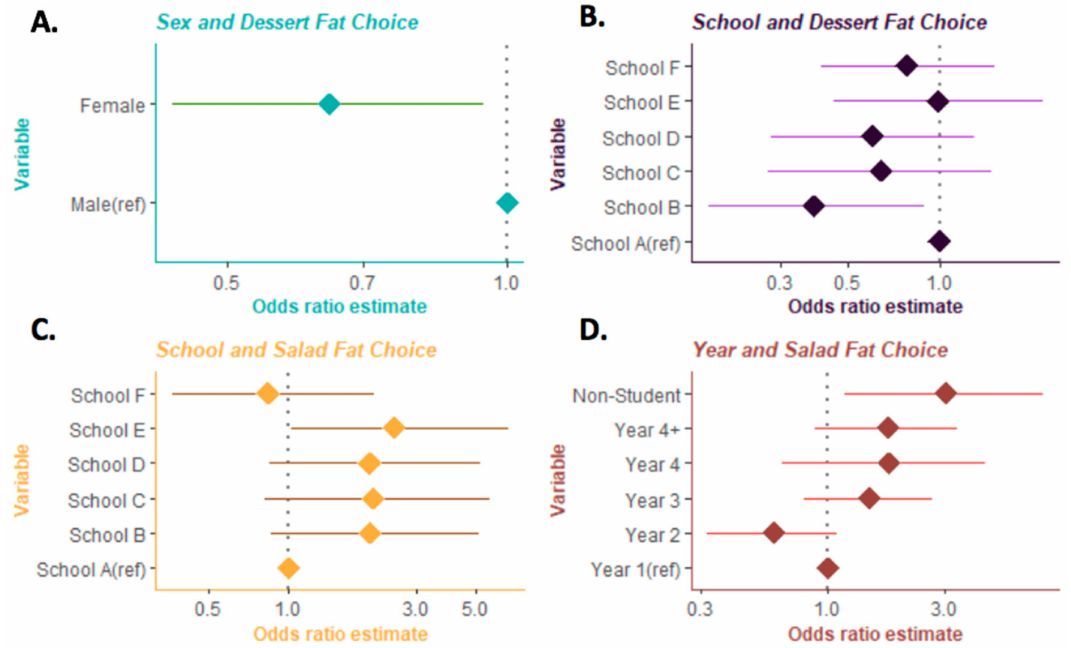
Figure 2. Estimating the odds ratio of variables with one or more associations. Each plate was transformed into a binary outcome based on unsaturated fat choice versus no-fat or saturated fat options. Plotted ORs of univariate logistic regression models that had at least one categorical level that associated with fat choice. ( A ) Females were less likely to choose the unsaturated fat dessert choice ( p = 0.024). ( B ) School B were less likely to choose correct dessert fat ( p = 0.026). ( C ) School E were more likely to choose the unsaturated fat salad fat than School A ( p = 0.058). ( D ) Non-students were more likely to choose unsaturated fat salad than baseline ( p =